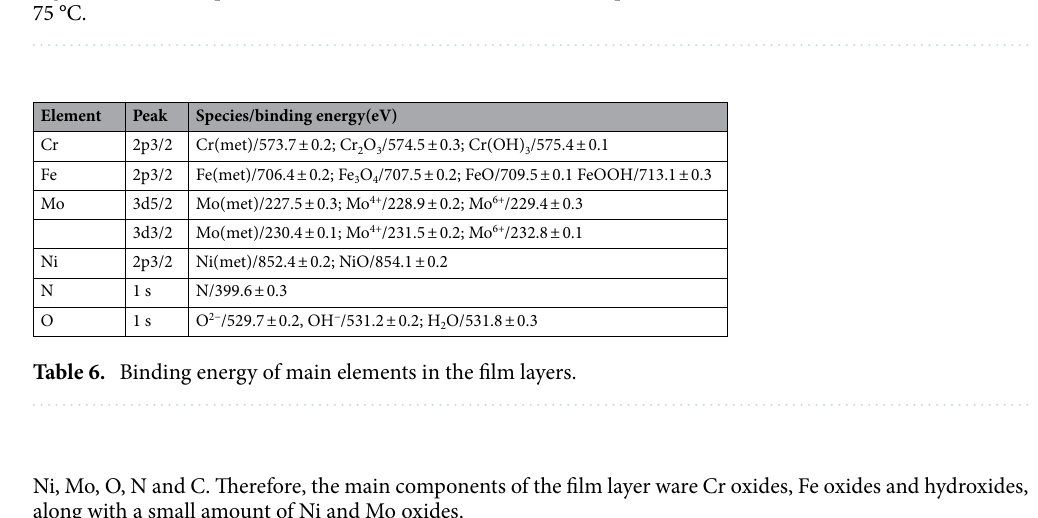
Figure 7. XPS full spectrum of 2205 DSS formed at different temperatures. ( a ) 30 °C, ( b ) 45 °C, ( c ) 60 °C, ( d ) 75 °C.